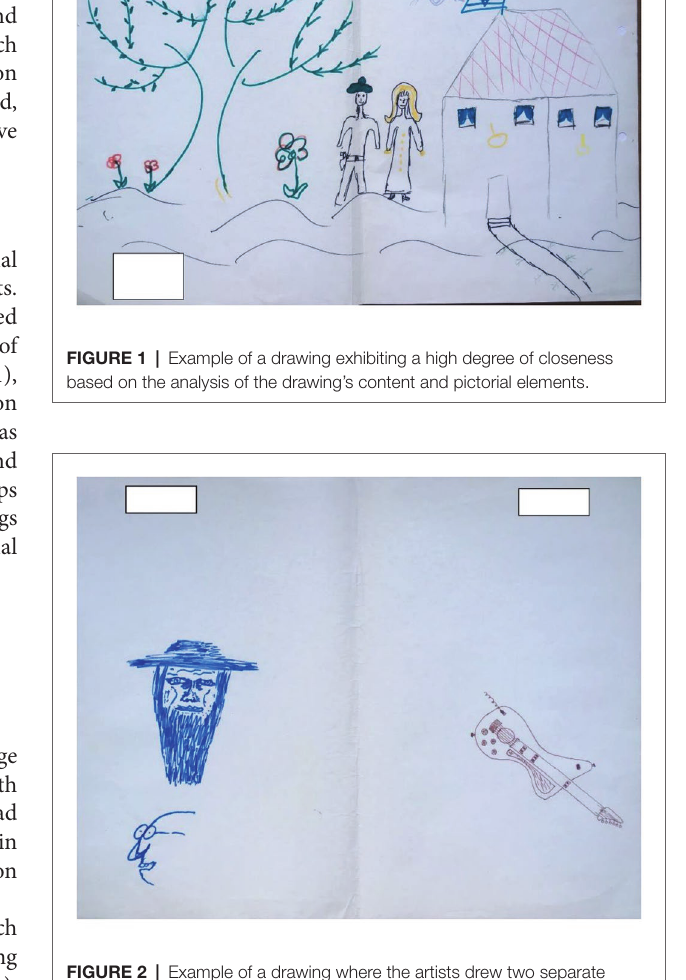
FIGURE 2 | Example of a drawing where the artists drew two separate pictures on the